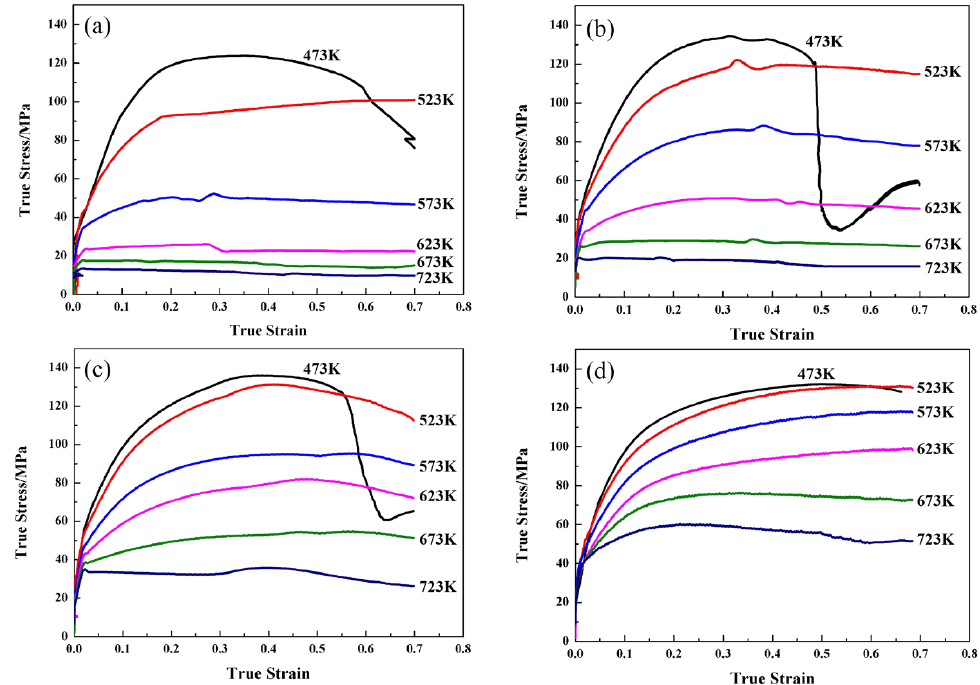
Figure 3. The true stress–true strain curves of the as-cast Mg − 2Sn − 1Ca magnesium alloy at different strain rates: ( a ) 0.001 s −1 ; ( b ) 0.01 s −1 ; ( c ) 0.1 s −1 ; ( d ) 1 s −1 .